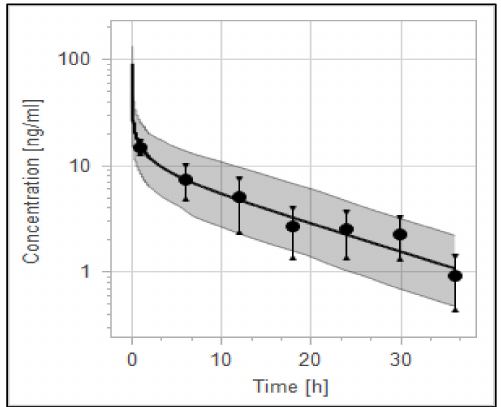
Figure 6. Concentration–time profile of haloperidol in TB